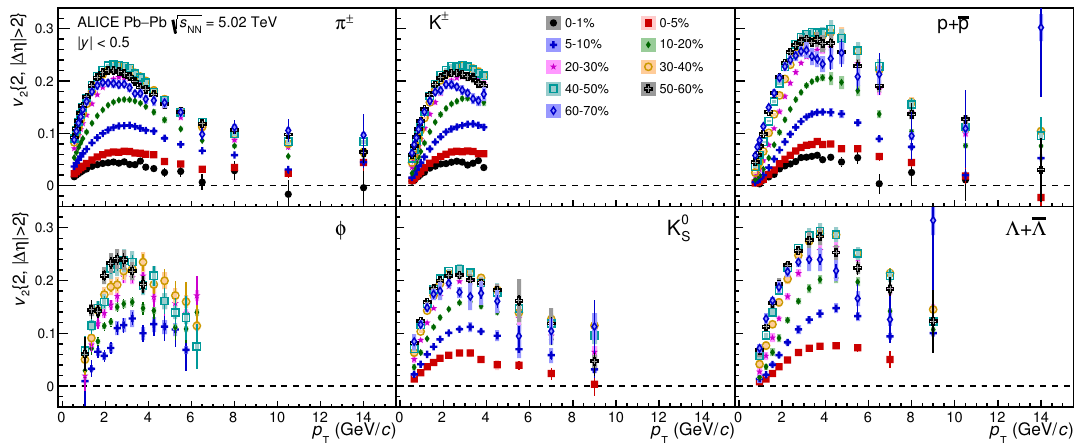
Figure 2 . (Colour online) Centrality dependence of v 2 ( p T ) for (cid:25) (cid:6) , K (cid:6) , p+p, (cid:3)+(cid:3), K 0 (cid:30) -meson. Statistical and systematic uncertainties are shown as bars and boxes, respectively.